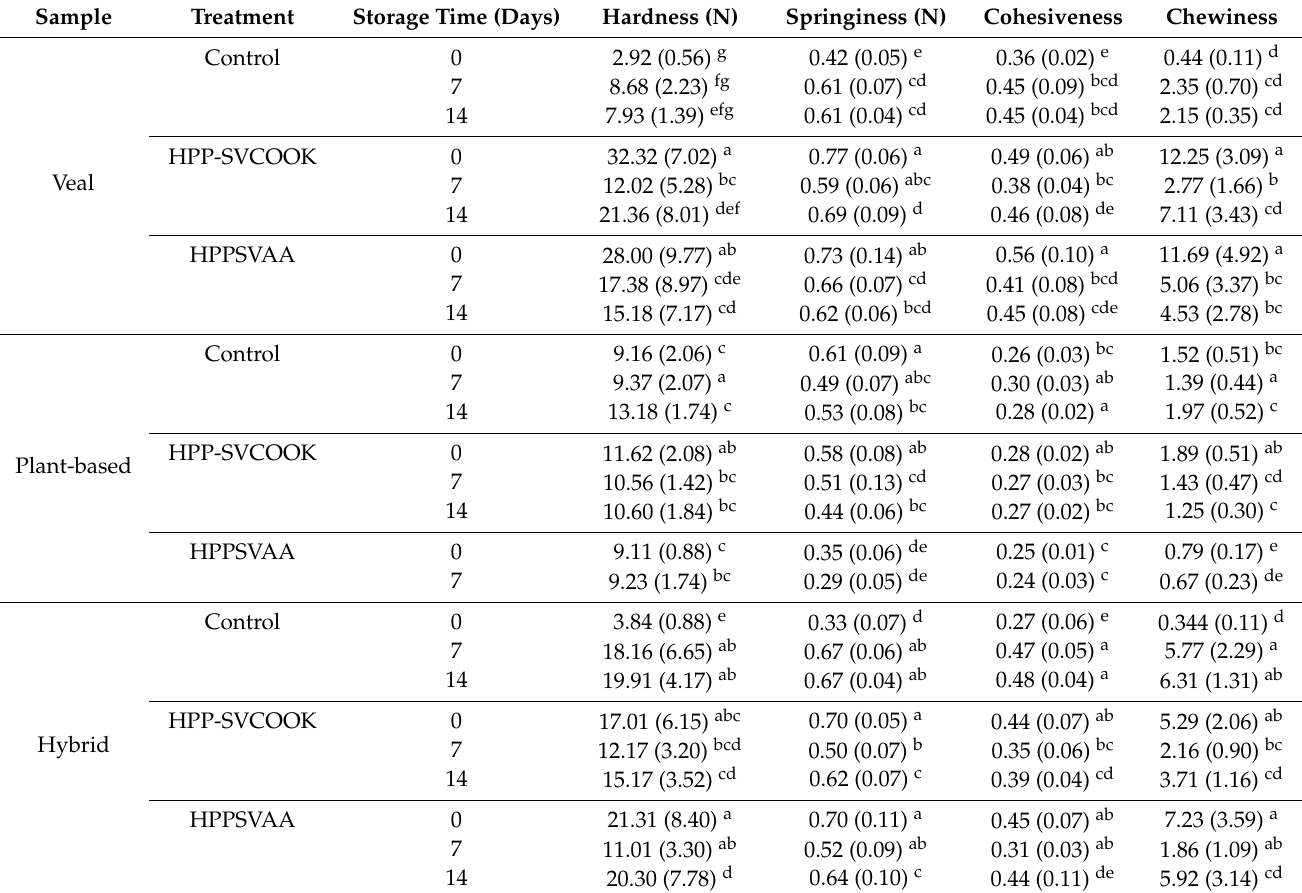
Table 3. Effect of treatments and storage time on texture parameters (mean value (standard deviation)) of veal, plant-based, and hybrid